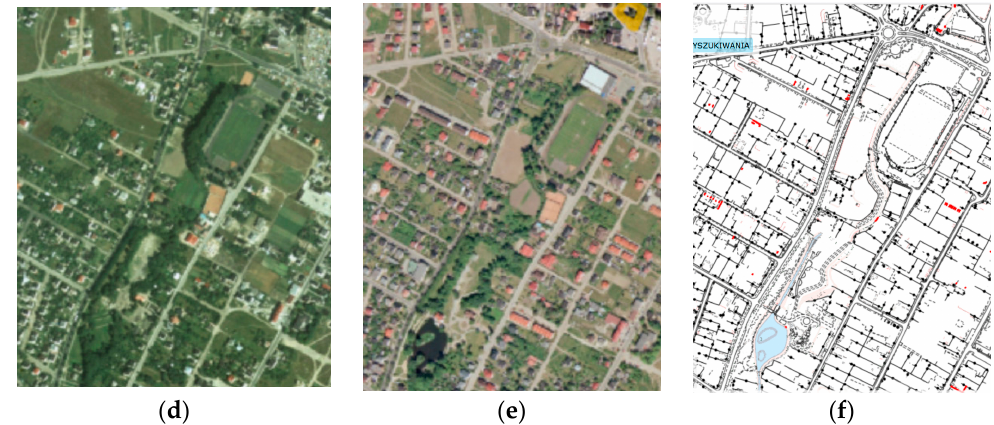
Figure 6. The reconstructed pond seasonal changes in water level ( a ) during summer ( b , c ) winter. Source: author .